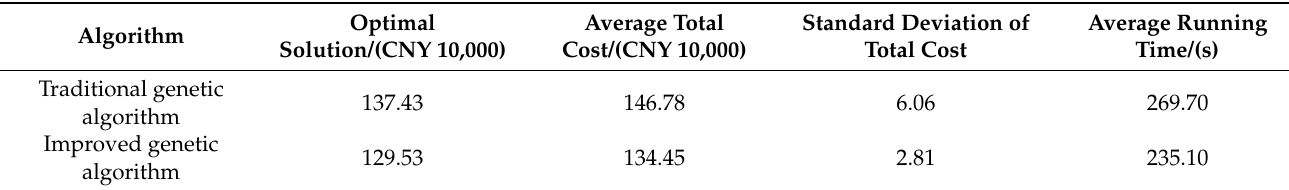
Figure 7. Comparison diagram of algorithm convergence. Table 9. Comparison of algorithm solution